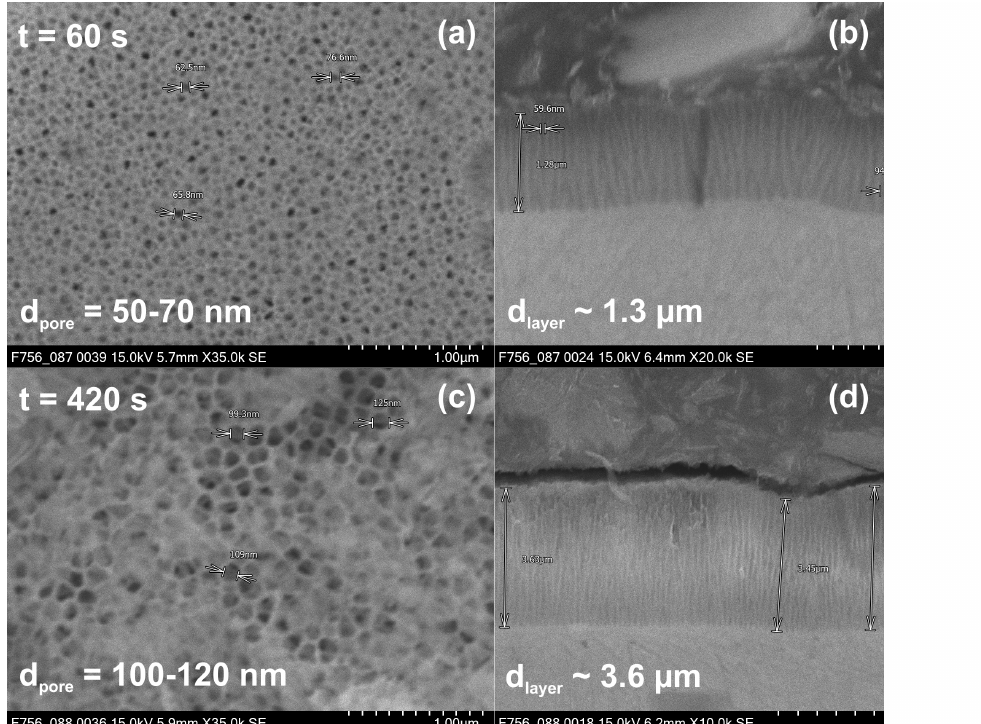
Figure 1. Influence of anodizing time on pore size and layer thickness (bath temperature 35 °C and